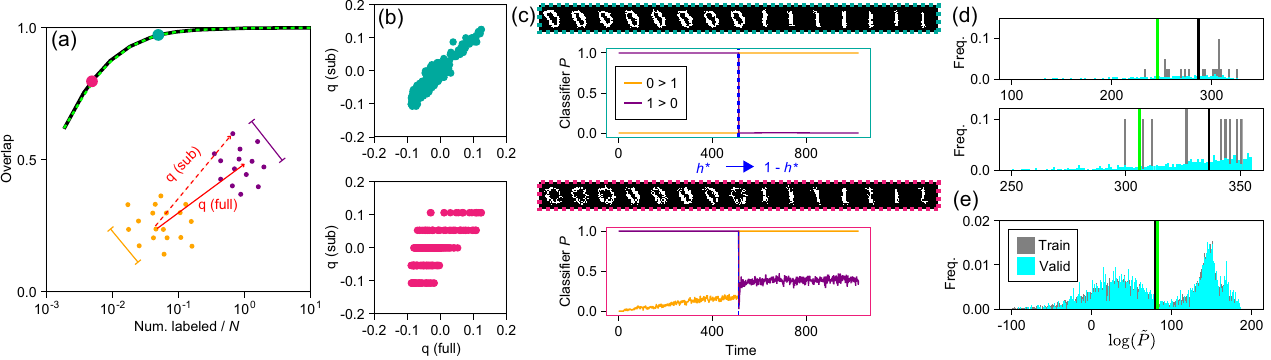
1 Þ FIG. 11. Semisupervised training with a subsampled labeled dataset. (a) Overlap (27) between q ð (computed on a subsampled- sub 1 Þ labeled dataset) and q ð (computed on the full dataset) plotted as a function of the number of labeled examples in the subsampled dataset full divided by the dimension ( 28 × 28 ¼ 784 for MNIST). An average of over 100 random realizations of the subsampled dataset is taken. The black solid curve shows the empirical result, while the dashed green curve is the theoretical estimate (30). Inset shows a diagram of how class separation relates to the overlap in connection to (30). (b) For the pink and cyan dots of (a), we plot an example of the obtained 1 Þ 1 Þ 1 Þ vectors q ð in comparison to q ð . (c) Label manipulation using the subsampled q ð in the two cases. (d) Histogram of log-likelihoods sub full sub of (subsampled) training and withheld dataset for a RBM trained on a subset of 0 (top) or 1 (bottom) digits, corresponding to the labeled datasets used in the cyan dot in the previous panels. The black and green vertical lines indicate the average values. (e) Histogram of log- likelihoods of training and withheld dataset of the partially constrained RBM in the cyan setting of the previous